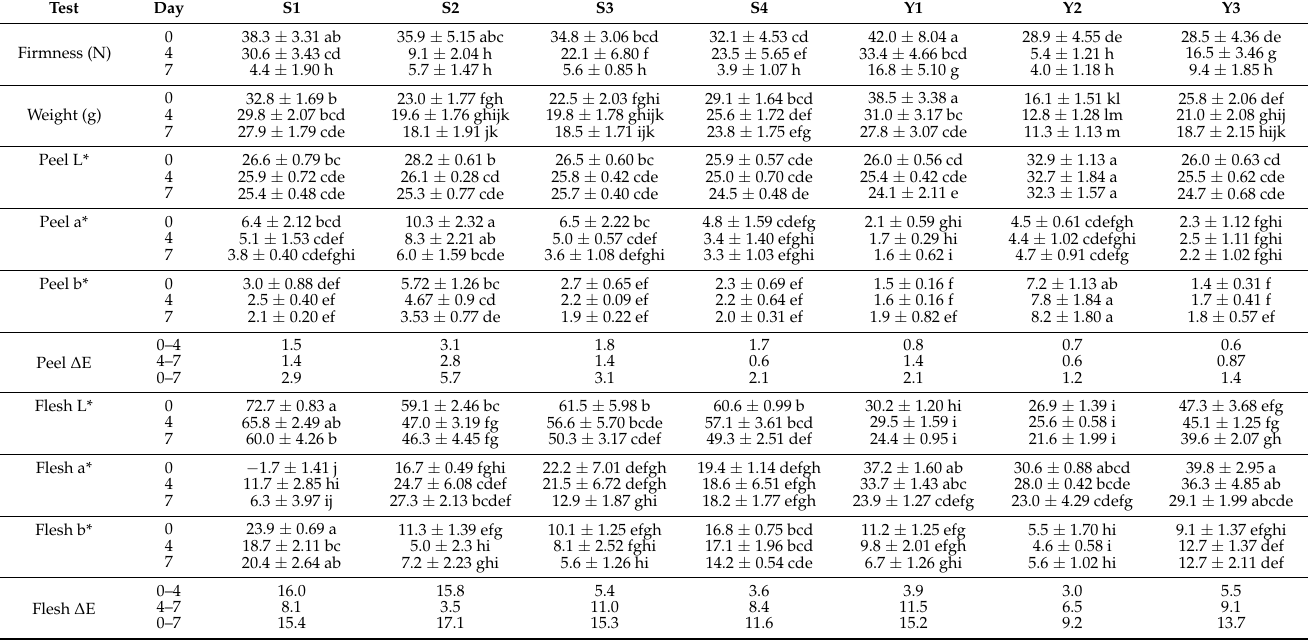
Table 3. Weight, firmness and color of the studied BP during ambient storage.